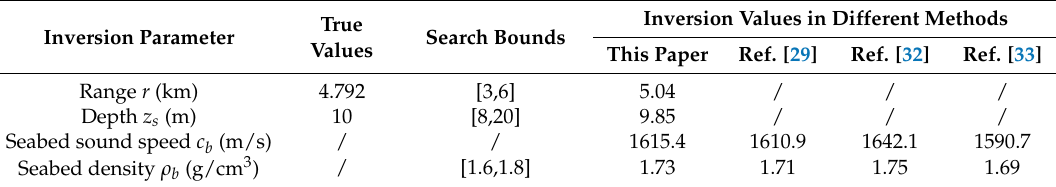
Table 2. Inversion parameter list. The search bound, true values, and inversion values are shown. (measured